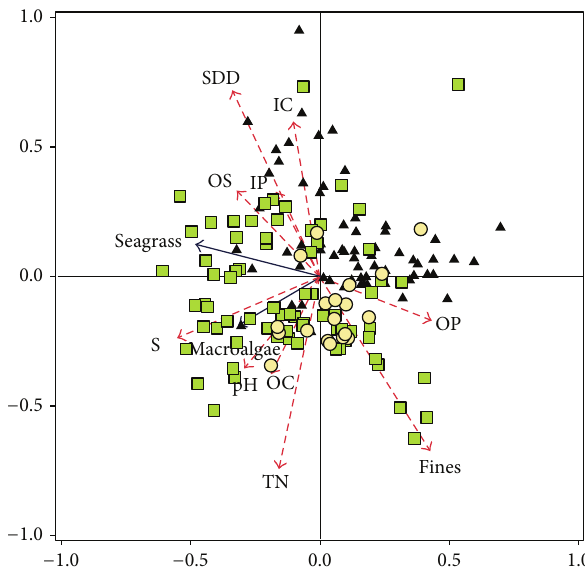
Figure 8: Redundancy analysis (RDA) for dataset including 165 observations in whole lagoon, 2 biotic factors (macroalgae and sea- grass), and 9 environmental variables: 𝑆 = salinity, pH, OS = oxygen saturation, fines = sediment fine fraction, TN = total nitrogen, IP = inorganic phosphorus, OP = organic phosphorus, IC = inorganic carbon, and OC = organic carbon. Black triangles represent central basin samples; green squares represent southern basin samples; yel- low circles represent northern basin samples. First and second axes explain 50.7% and 16.7% of variation,